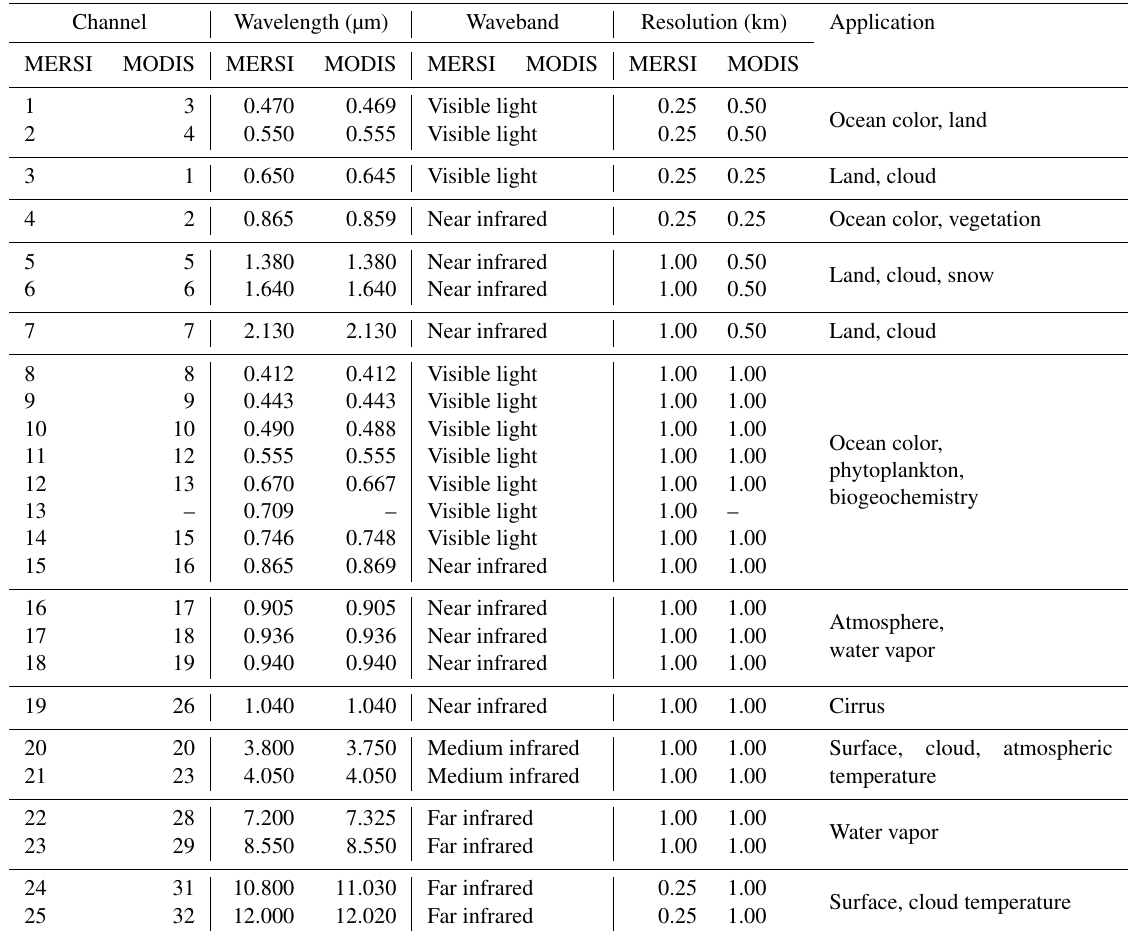
Table 1. Major channel parameters of FY-3D MERSI-II (compared with